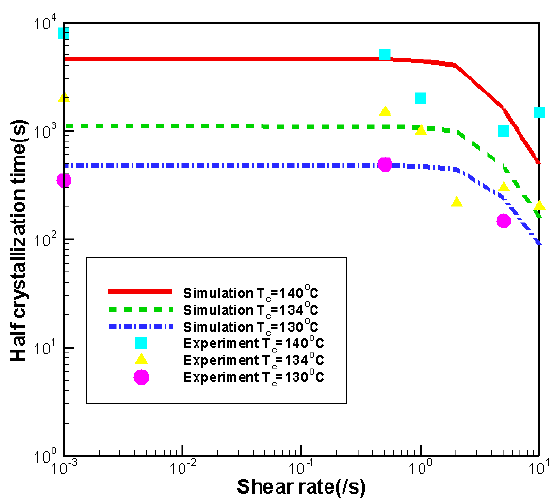
Figure 3. Comparison of simulation result with the experimental result [7].